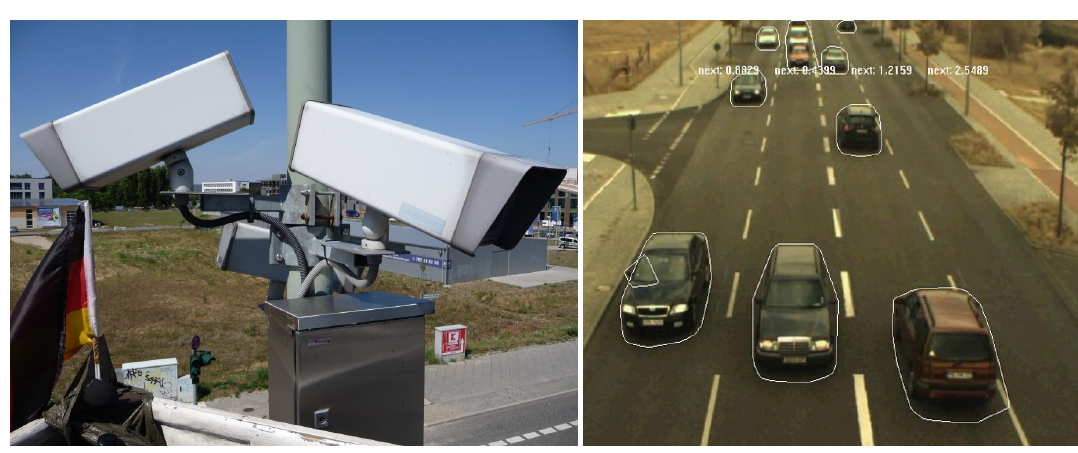
Figure 4: Traffic cameras and video